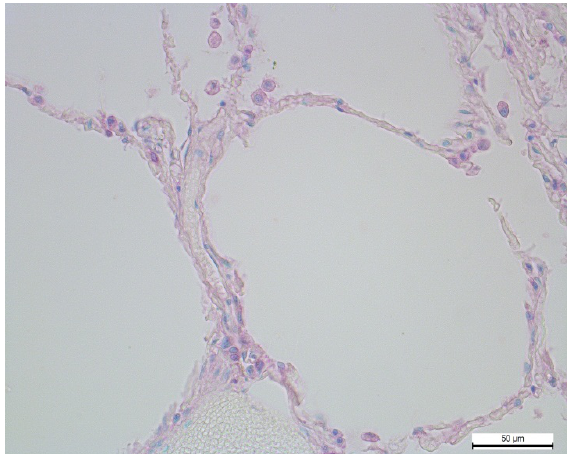
Fig. 12 Б. Acute expansion of the lumen of the alveoli. Single lymphocytes and macrophages in the lumen of enlarged alveoli. Brache. EP 10, lens 40